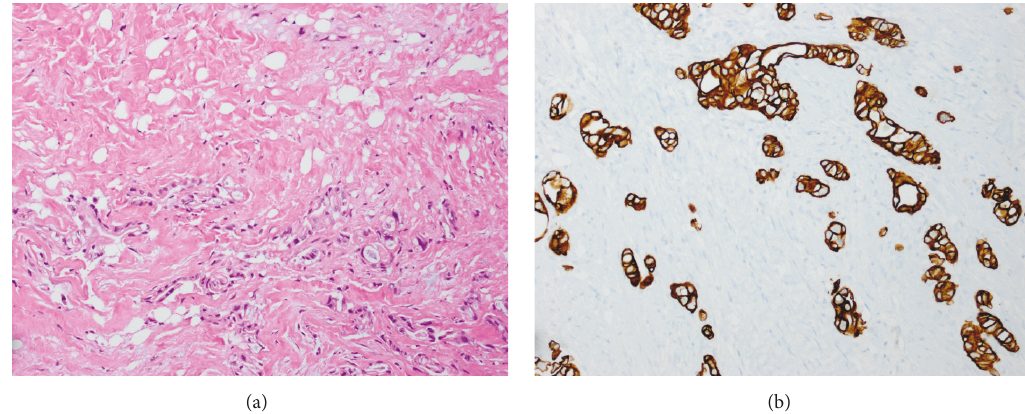
Figure 1: (a) Diffuse infiltration of the connective tissue by neoplastic cells with hyperchromatic nuclei, inconspicuous nucleoli, and abundant eosinophilic cytoplasm (hematoxylin-eosin, original magnifications: x200). (b) Neoplastic cells are strongly positive for CK7 (immunohistochemistry, original magnifications: x200).